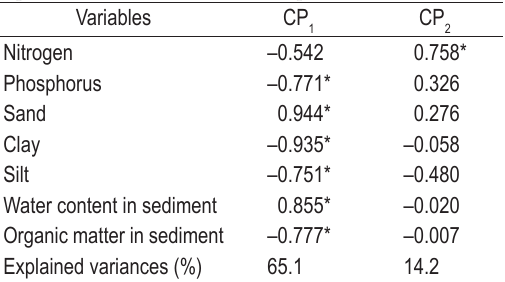
Table 2. Correlation of abiotic factor values with axis ordination of principal components (CP explained variances for each component